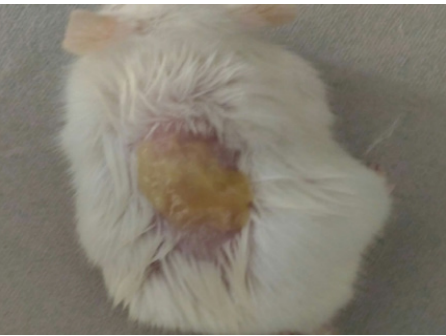
FIGURE 12(a ) - Mice skin for observation of erythema at 0 h.